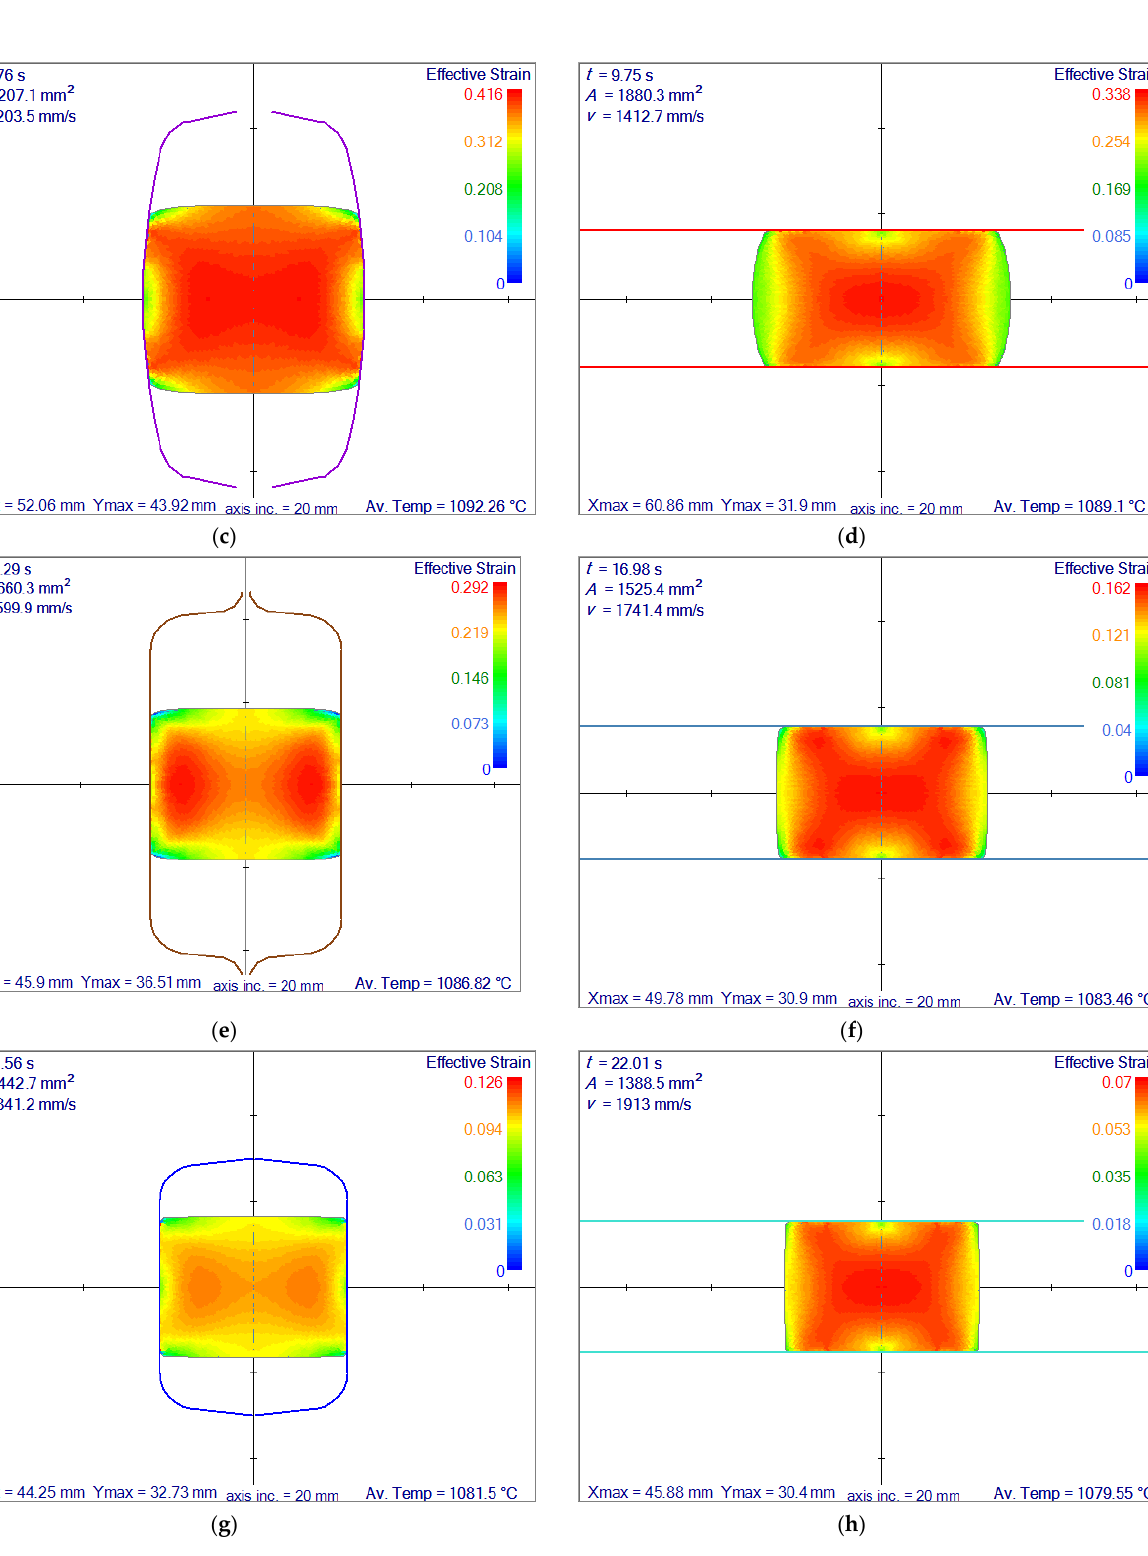
Figure 12. Simulation results of effective strain at the exit of each roll pass. ( a ) at first roll pass, ( b ) at second roll pass, ( c ) at third roll pass, ( d ) at forth roll pass, ( e ) at fifth roll pass, ( f ) at sixth roll pass, ( g ) at seventh roll pass, ( h ) at eighth roll pass. Axis inc. is the length of axis increments. Av. Temp. stands for average temperature.